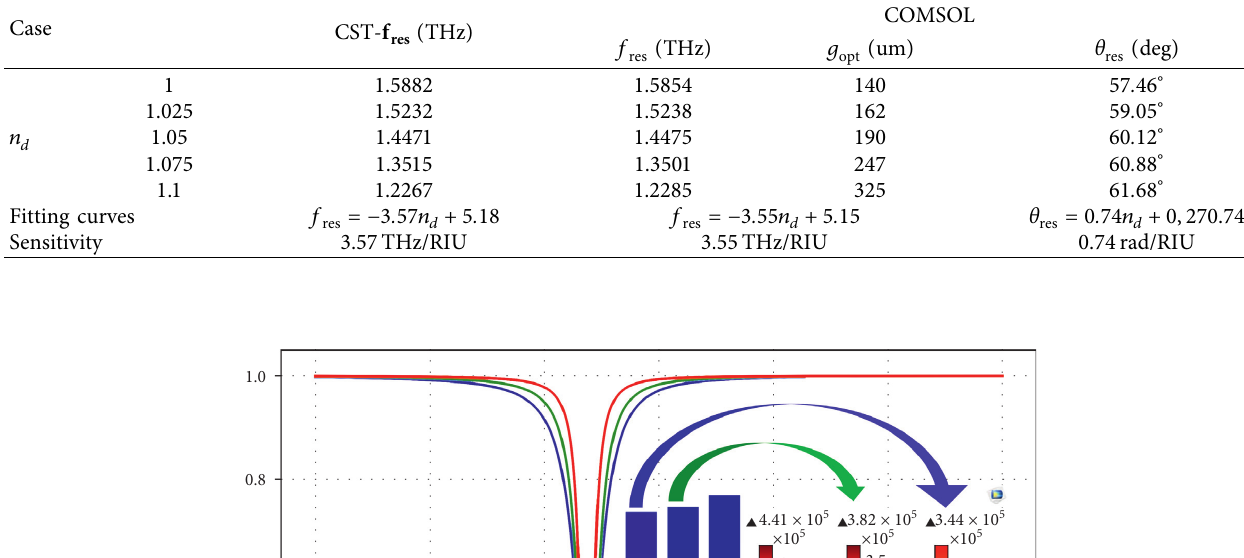
Table 1: Data comparison based on two numerical